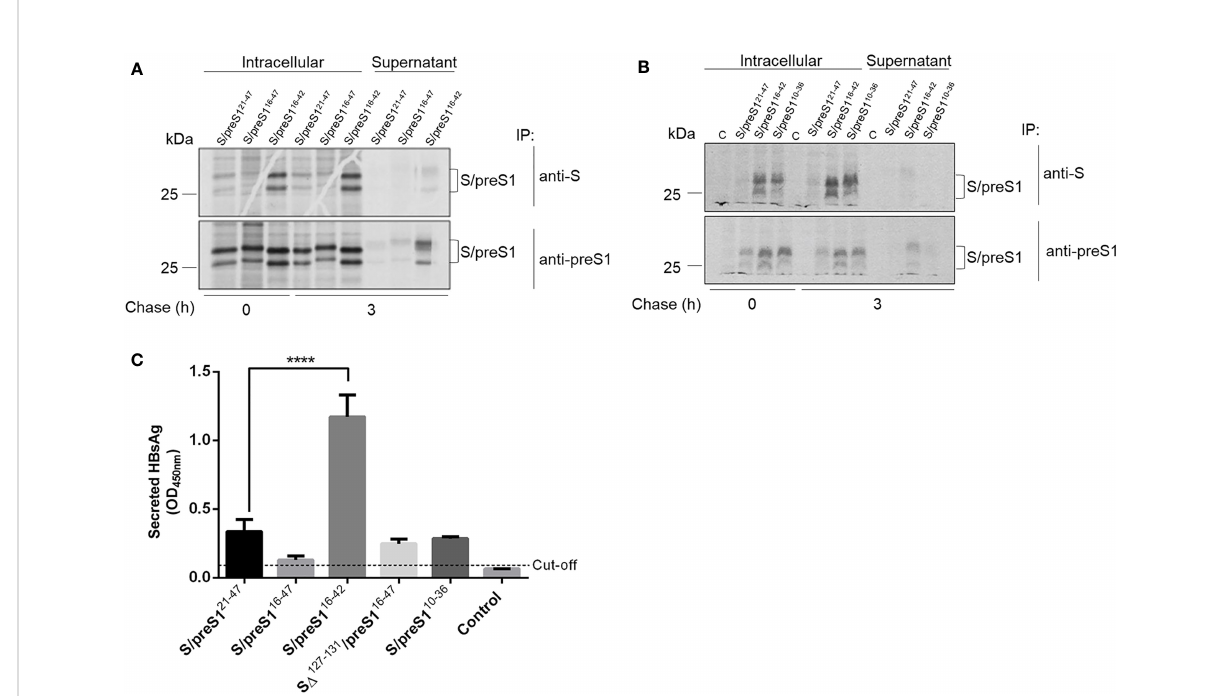
FIGURE 3 Antigenicity of novel HBV S/preS1 antigens produced in mammalian cells. (A, B) HEK293T cells transfected with pCi plasmids encoding the indicated antigens or the empty pCi plasmid as control (C) were pulse-labelled with 35 S-protein labelling mix for 30 min and chased for 3 h. Cell lysates and supernatants were immunoprecipitated with either anti-S, or anti-preS1 antibodies and bound proteins were separated by SDS-PAGE and visualized by autoradiography. (C) HEK293T cells were transfected with pCi plasmids encoding the indicated antigens or the empty pCi plasmid as control (Control) for 72 h. Secretion of the HBsAg was quanti fi ed by ELISA in cell supernatants and represented as optical density values measured at 450 nm (n=3). Data are represented as means ± SD; Student ’ s unpaired t test (**** p <